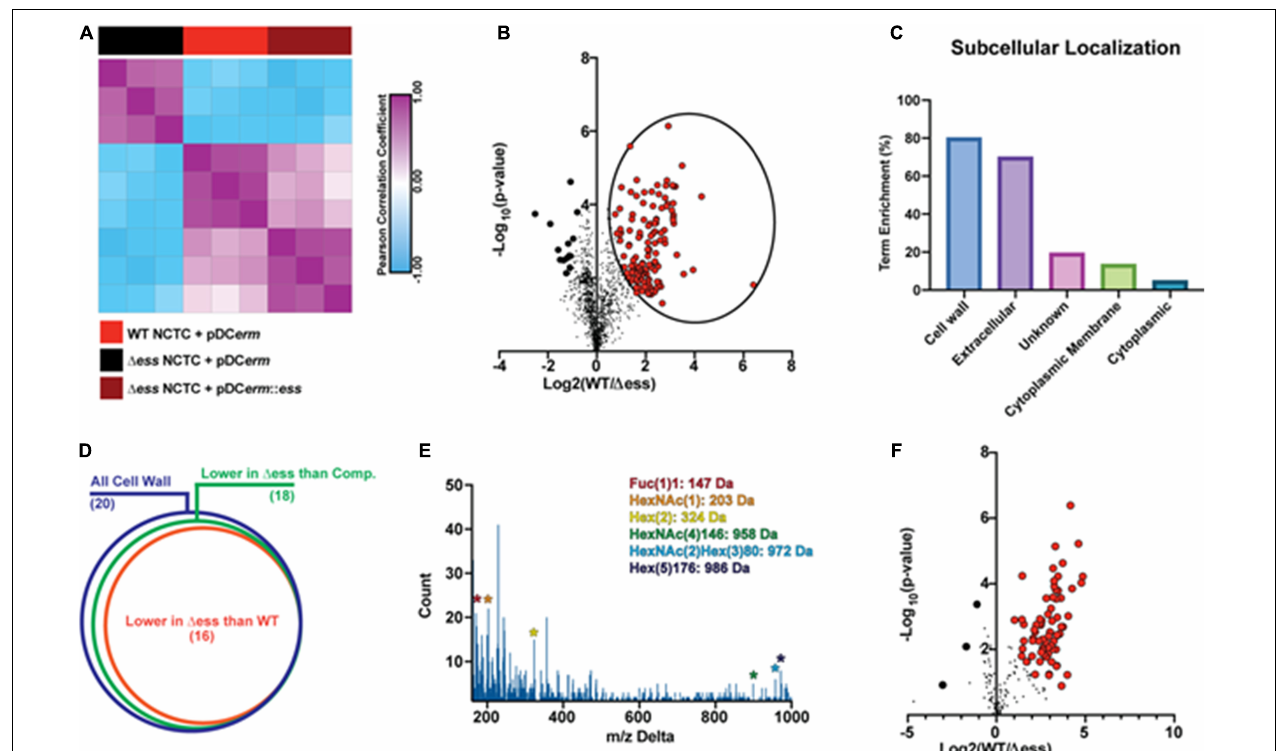
FIGURE 3 | GBS S protein stabilizes the surface-anchored virulome. (A) Similarity matrix demonstrating Pearson correlation values for proteome quantitation data following hierarchical clustering. (B) Binary comparison strategy for identifying differentially abundant proteins in the surfome samples collected from WT and S protein deletion mutant GBS strains. Proteins significantly higher in WT compared to the deletion mutant are circled. Proteins with π score value greater than 2.5 were highlighted for further analysis. (C) Results of pSORTb analysis of proteins significantly upregulated in WT GBS in comparison to the S protein deletion mutant. Data are reported as the percentage of significantly increased proteins in a given location within the total number proteins assigned a location. (D) Venn diagram showing proportion of all cell wall proteins identified upregulated in WT or complemented strains compared to the S protein deletion strain as a proportion of all cell wall proteins. (E) Delta m/z histogram of PTM-inclusive search of surfome data with putative glycans highlighted. (F) Binary comparison of glycosylation-inclusive data for WT vs. S protein deletion surfome data. Glycopeptides with differential abundance π score greater than 2.5 are